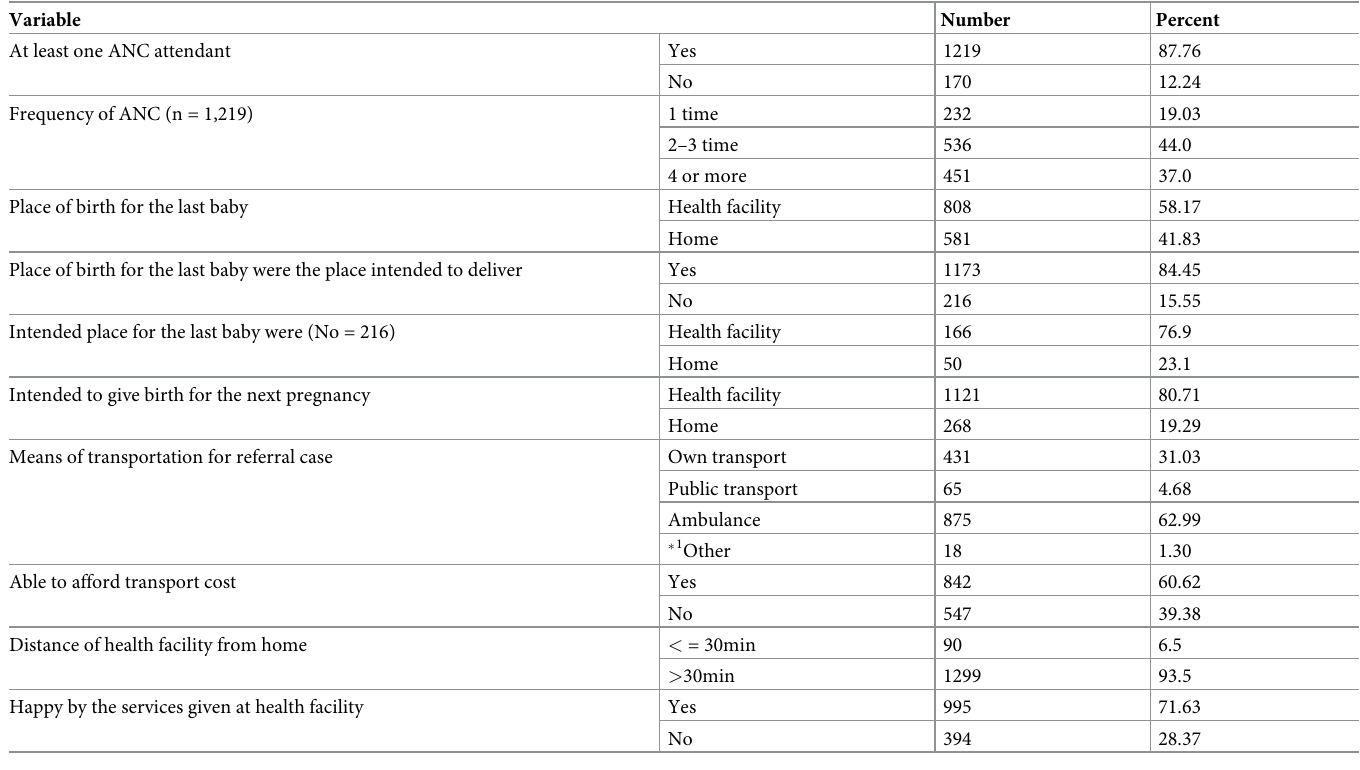
Table 3. Institutional delivery and ANC by women in Wogera and East Dembiya District, North west Ethiopia, 2020.